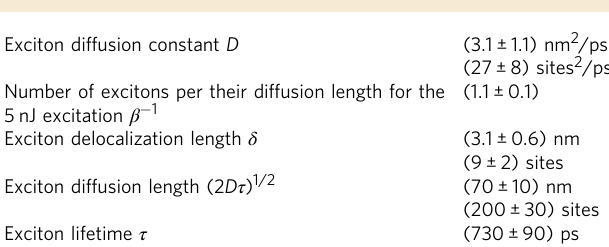
Table 1 Physical parameters characterizing the exciton in MEH-PBI aggregate determined from fi tting the experimental